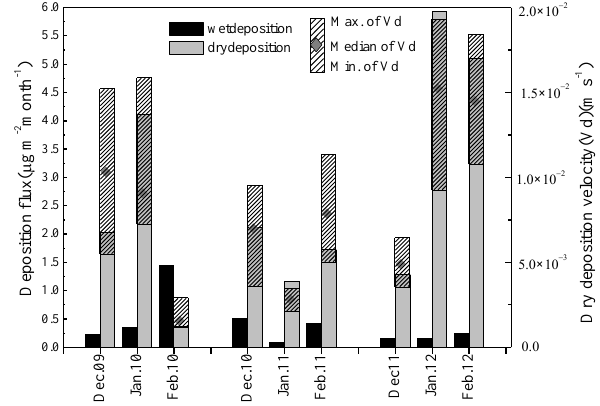
Fig. 7. Dry and wet deposition fluxes, and dry deposition velocity (V d ) of EC on snow 703 surface in winter seasons from 2009 to 2011. 704 705 ( V d ) of EC on snow surface in winter seasons from 2009 to